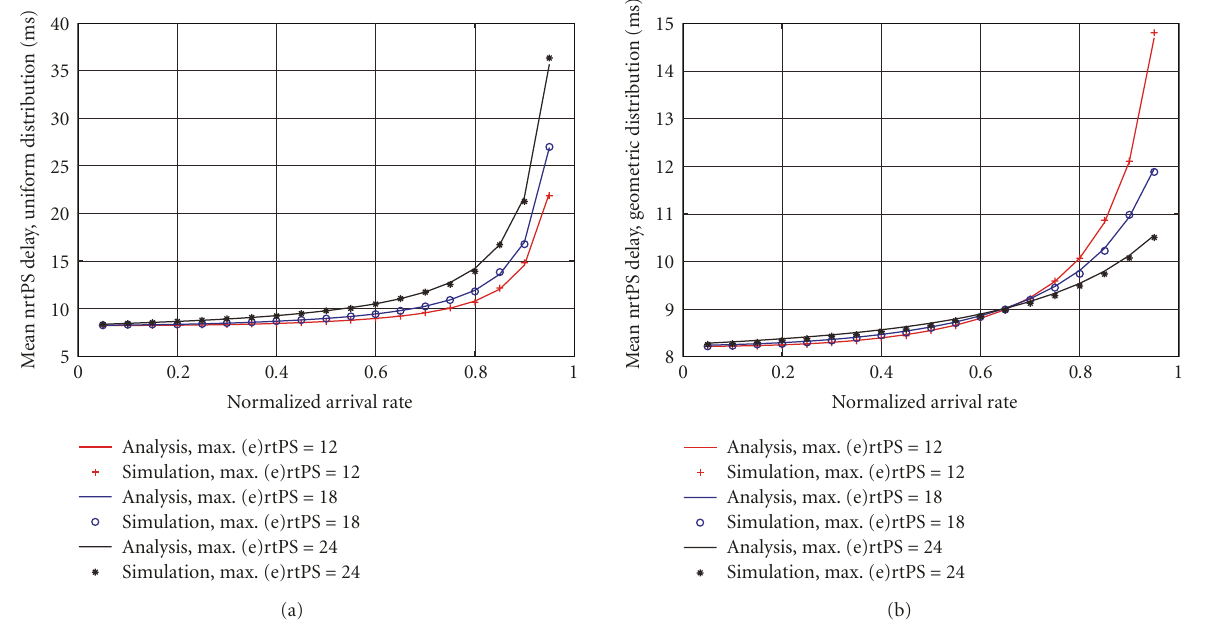
Figure 12: Influence of (e)rtPS tra ffi c on the mean nrtPS packet delay in symmetric system ( N = 6) for uniform distribution (a) and for truncated geometric distribution with parameter 0.5